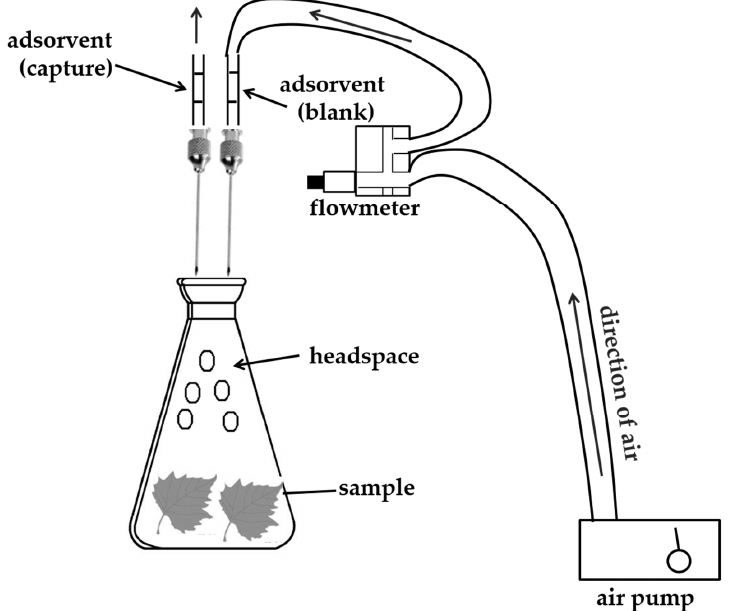
Figure 5. Scheme of volatile compounds sampling by dynamic headspace using Porapak Q (HSD-P) and peat as adsorbent (HSD-P).